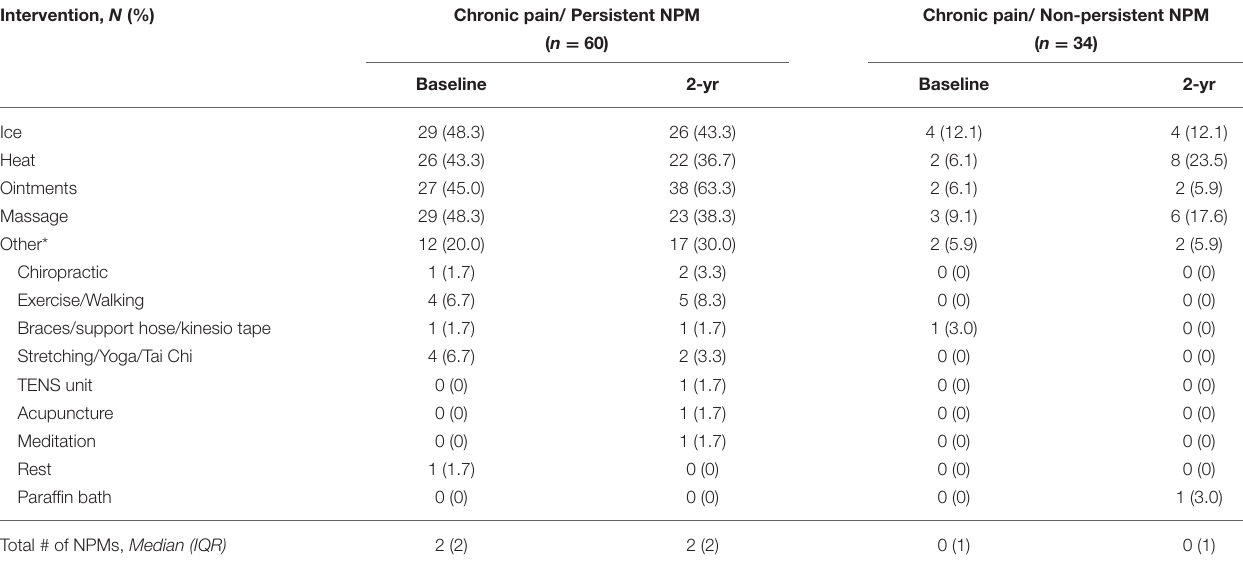
TABLE 2 | Type of non-pharmacological pain management reported at each time point by pain/NPM group. Intervention, N (%) Chronic pain/ Persistent NPM Chronic pain/ Non-persistent NPM